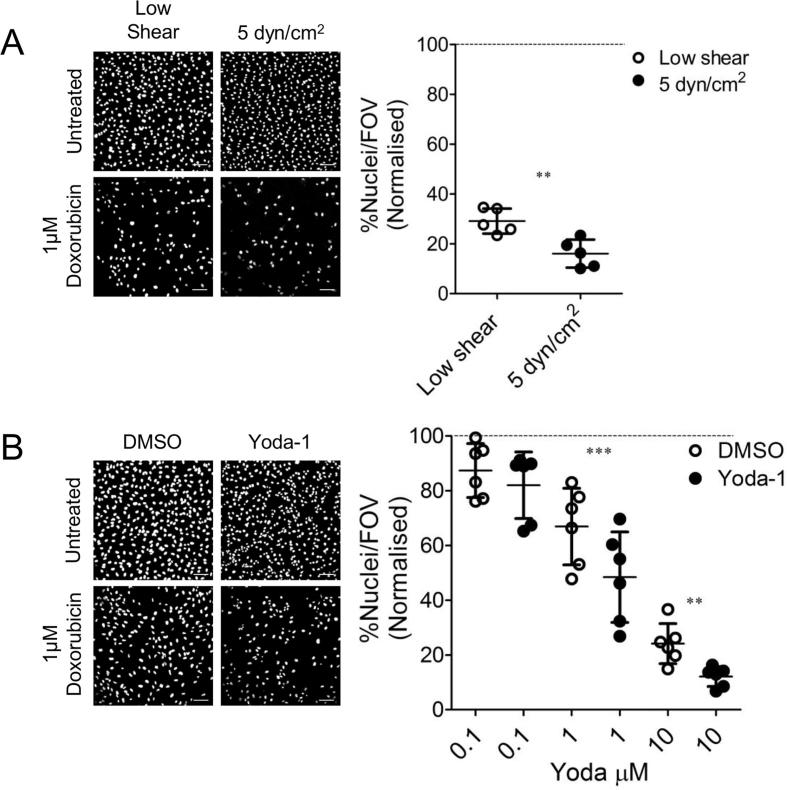
Yoda-1 and laminar shear stress increase endothelial cytotoxicity in response to doxorubicin. (A) HUVEC were either placed under 5 dyn/cm2 or low flow conditions (see materials and methods for description) for 24 h prior to the addition of 1 µM doxorubicin. Constant flow then continued for a further 24 h. Representative confocal images of stained nuclei are shown (Scale bar = 100 μm). Per condition 6 random fields of view were selected and imaged through confocal microscopy. Data represent the number of nuclei present in the field of view (FOV) as a percentage of the appropriate no doxorubicin control. Each circular point represents one independent experimental repeat recorded on a different day. Dashed line indicates normalisation. Two-tailed non-paired t-test conducted, **P < 0.001. (B) HUVEC were grown either with 1 μM Yoda-1 or the DMSO (vehicle) control for 24 h, then challenged with doxorubicin for a further 24 h. Yoda-1 or DMSO was not removed during this period. HUVEC were then imaged as described above. Scale bar = 100 μm. Two tailed paired t-test conducted, **P < 0.001, ***P < 0.0001.